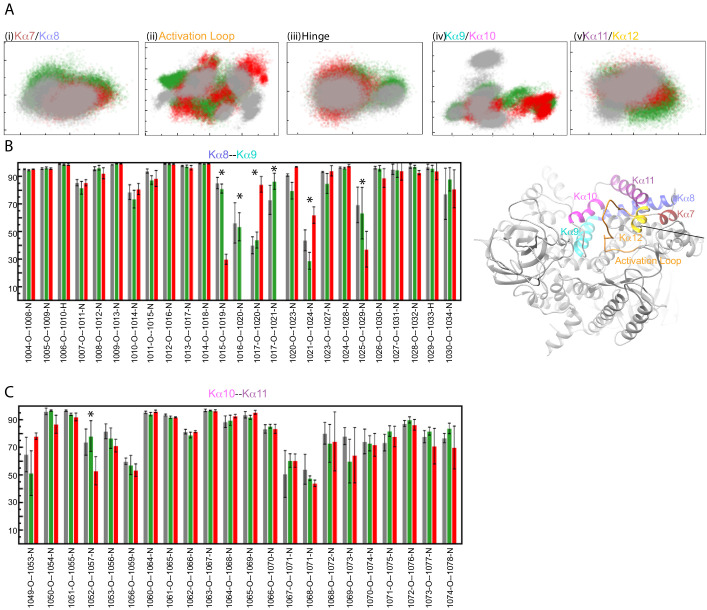
Differences between molecular dynamic simulations of WT, R1021C, and R1021P.(A) Principal component analysis (PCA) plots showing PC1 vs. PC2 of Kα7/8 (989–1023), Activation loop (962-988), hinge (879-887), kα9/10 (1024–1054), and kα11/12 (1057–1088) for WT (grey), R1021C (green), and R1021P (red) (B–C) The mean and standard deviation of hydrogen bonding occupancies between kα8 and kα9 (B), kα10 and kα11 (C) across replicates for WT (grey), R1021C (green), and R1021P (red). Asterisks indicate significant differences between WT and mutants. (D) Model of p110γ showing helices in the C-terminal regulatory motif and the activation loop.